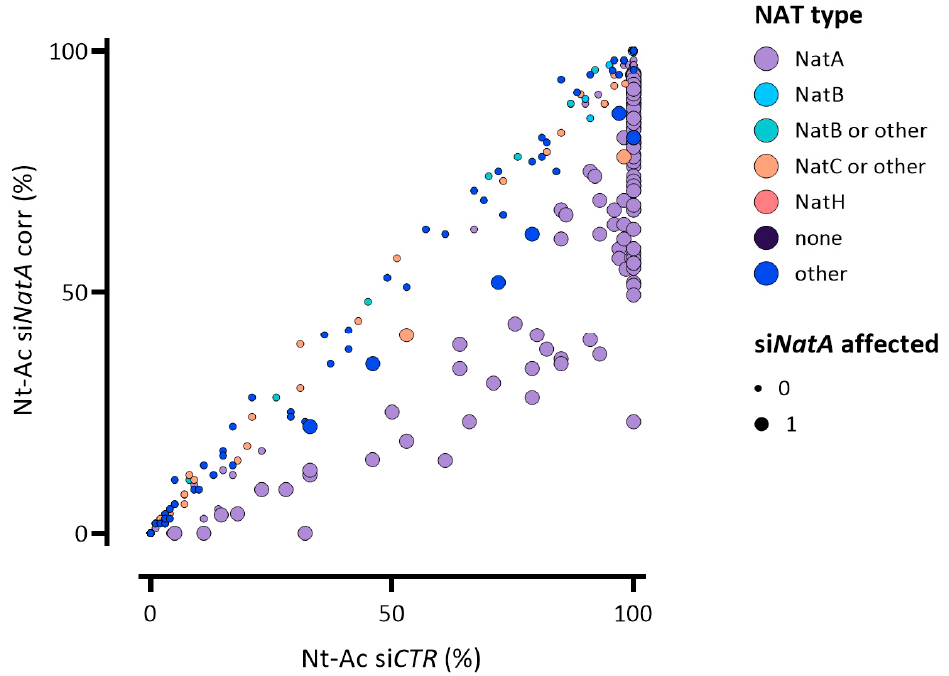
Figure 2. The effect of si NatA knockdown on the Nt-acetylome. The scatterplot displays the corre- lation of the determined degrees of NTA when comparing the si CTR (X-axis) and si NatA (Y-axis) N-terminome datasets (n=1404). The enlarged dots (si NatA affected = 1) represent N-termini dis- playing a significant reduction in the degree of NTA upon si NatA knockdown. The circles are colour coded according to their indicated NAT substrate specificity profiles (see also NAT type column in Tables S1,S2). si NatA knockdown causes a decrease in the levels of NTA as compared to the si CTR setup especially in case of NatA type N-termini (purple dots).